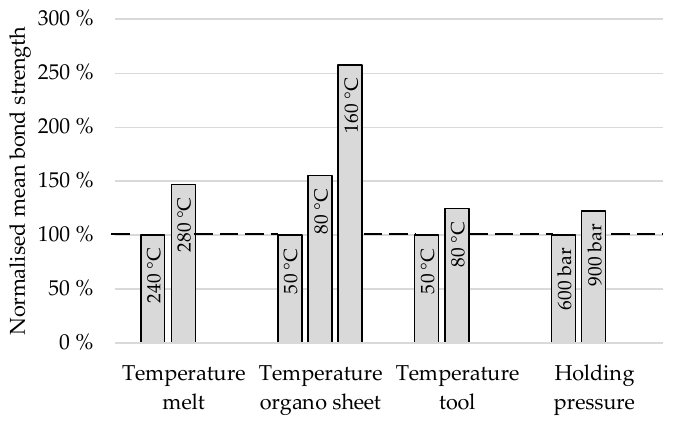
Figure 8. Influence of the process parameters on the potential increase in bond strength.